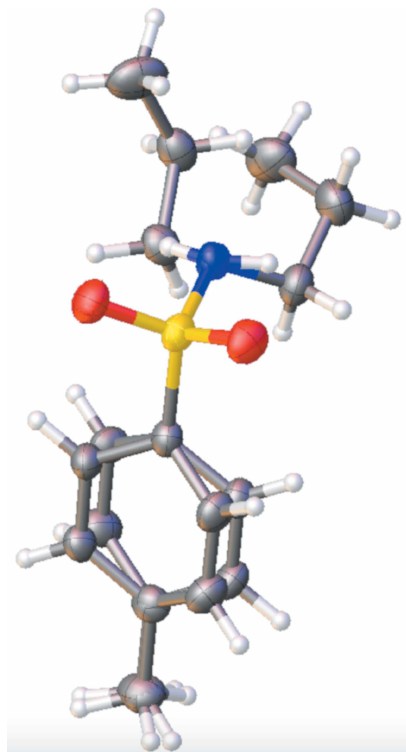
Figure 3 Overlay plot of the two independent molecules in the title compound, with grouping of the atoms C1—S1—-N1 and C1 A —S1 A —N1 A , and the molecule oriented so as to view it down the S—N bond. Displacement ellipsoids are as in Fig.